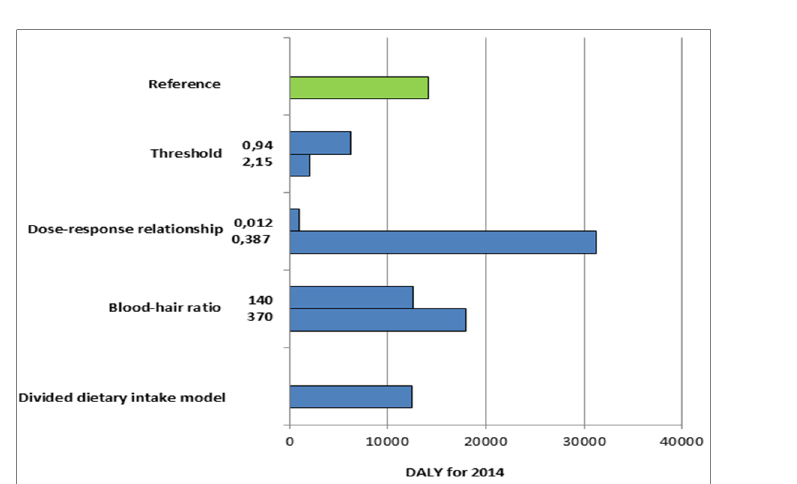
Fig 3. Results of the scenario analysis. Disease burden of the 2014 birth cohort in Germany for high fish, only pollack and only tuna consumers.